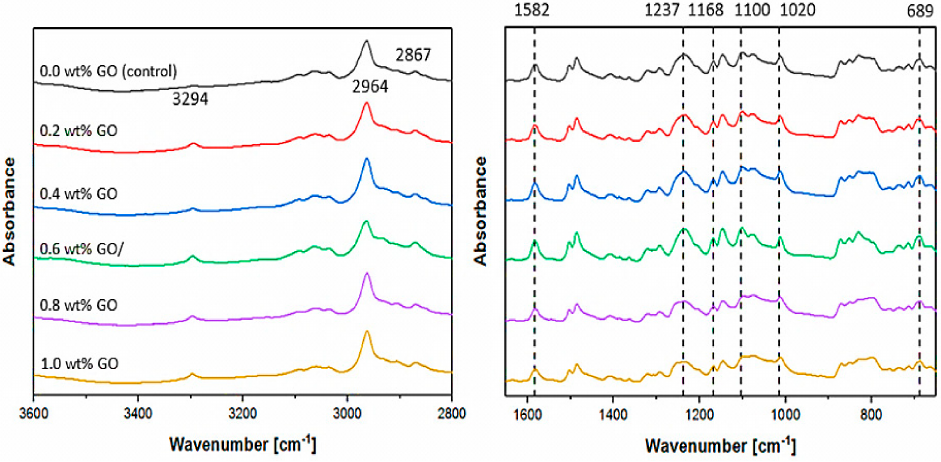
Figure 3. FTIR spectra of multilayer-coated membranes with di ff erent GO